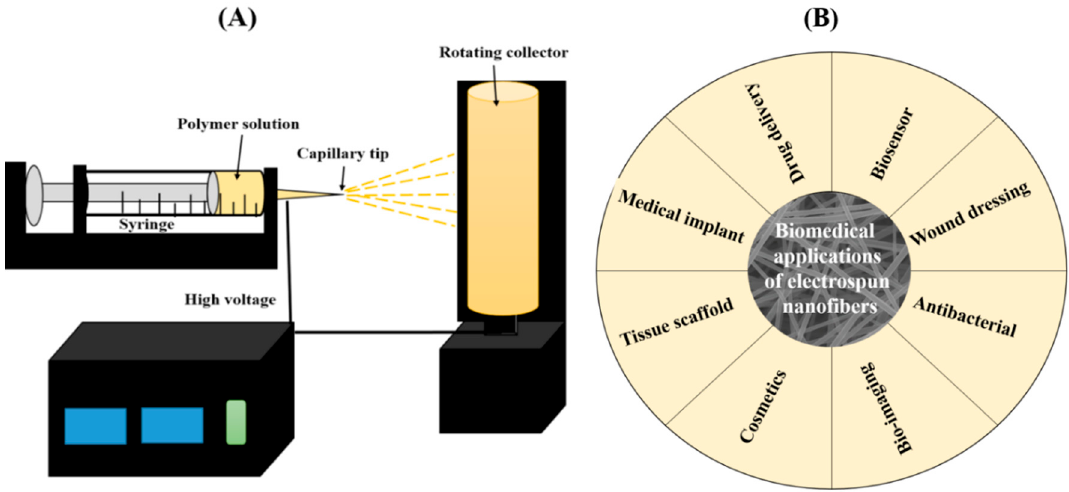
Figure 1. ( A ) Schematic diagram showing the electrospinning setup and ( B ) various biomedical applications of electrospun nanofibers.